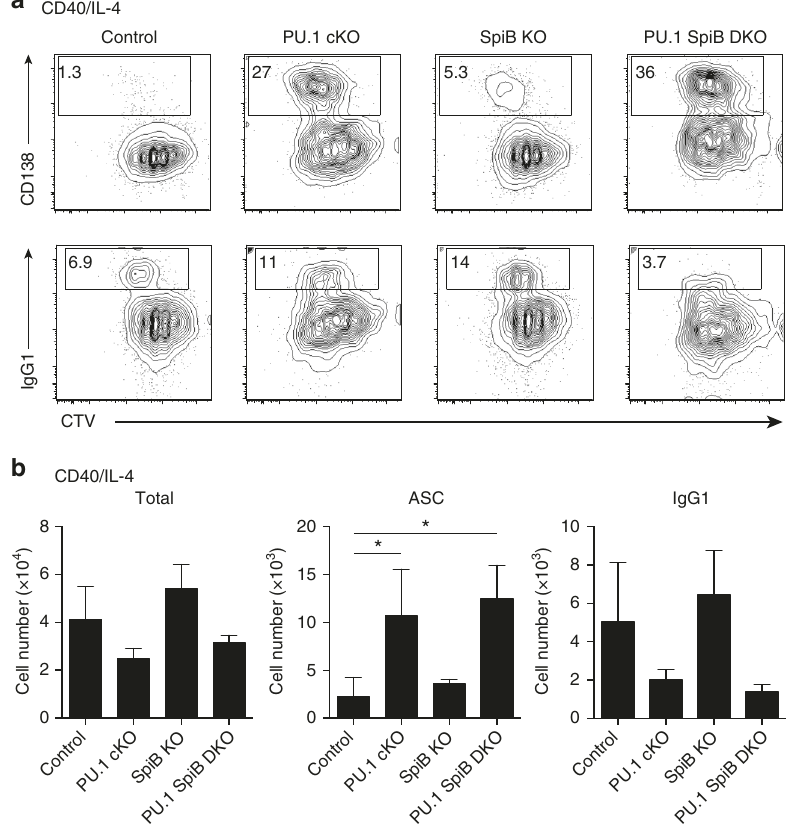
Fig. 4 PU.1 and SpiB repress antibody-secreting cell differentiation in vitro. a Resting lymph node B cells from mice of the indicated genotype were labeled with CTV and cultured in the presence of CD40 L + IL-4 for 4d before fl ow cytometric analysis. Numbers in the boxes are the proportion of CD138 + ASC or IgG1 + B cells. The full gating strategy is shown in Supplementary Fig. 9A. Data are representative of three independent experiments. b Quantitation of the total cell number (left), total number of ASCs (middle) and IgG1 + cells (right) cultured as in a is shown after 4d of culture. Data are the mean ± s.d. for three independent experiments. P -values compare the indicated samples (two tailed t -test). * P <